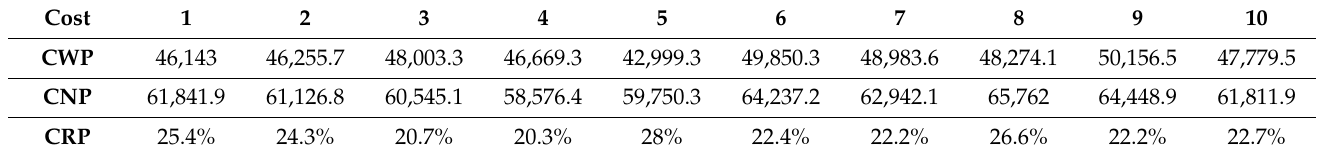
Table 3. Computational results of the first instances set in Case 3.